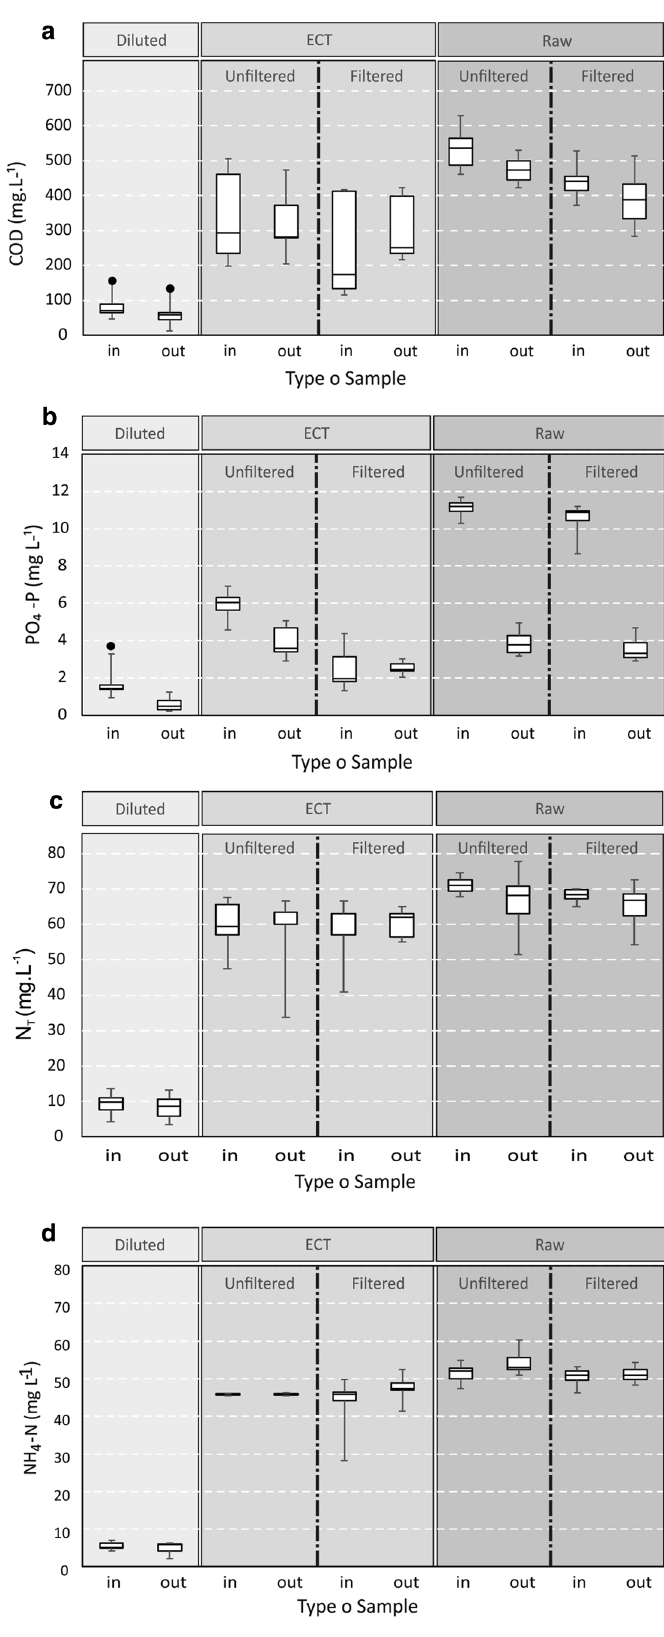
Fig. 7 Effects of the disinfec- tion process on the concentra- tion and speciation of organics (COD) and nutrients (N, P) in the treated